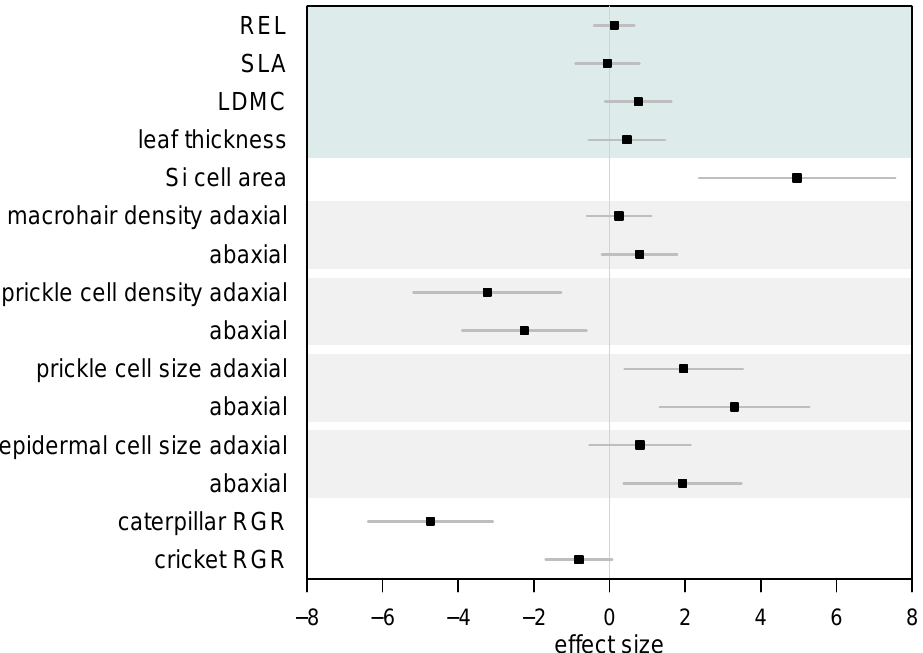
Figure 5. Standardised e ff ect sizes ( ± 95% CI) of the influence of Si on leaf traits and herbivore growth. Whole leaf mechanical traits are grouped (top shaded area) for clarity. Shaded bars show pairings of adaxial and abaxial measurements. Positive e ff ect size indicates higher values under Si supplementation. Bars that overlap zero indicate a nonsignificant e ff